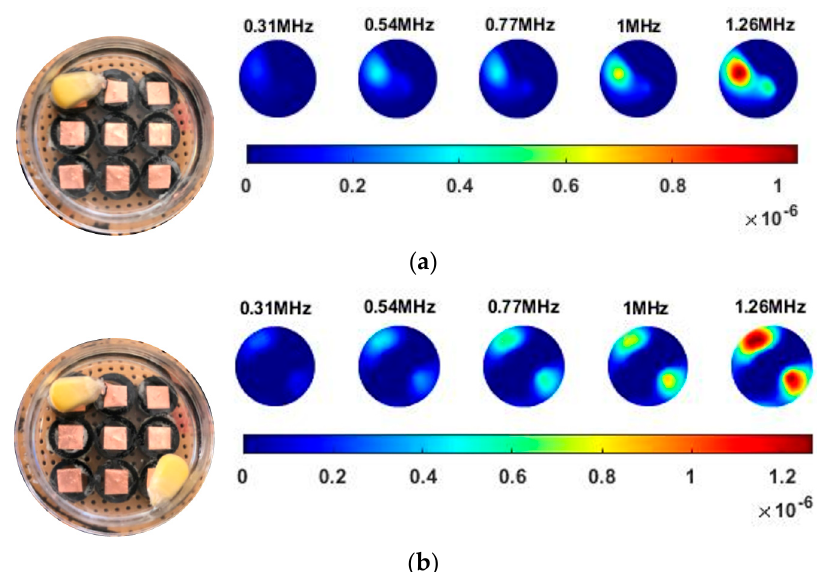
Figure 14. Experiment scenarios for the miniature planar CCERT sensor and the reconstructed 2D results ( a ) Single corn kernel. ( b ) Double corn kernels. (Colorbar units: mS / cm).